Question: Give a one-sentence summary of this figure.
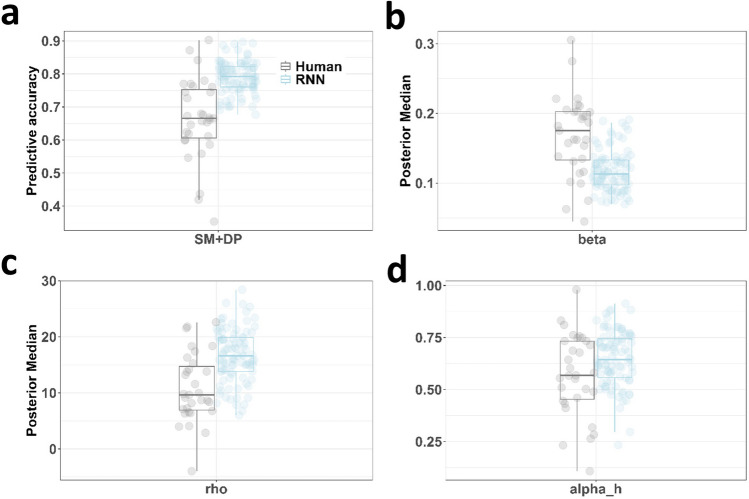
Answer: Median posterior values of model parameters for the best-fitting model for RNN agents (Bayesian learner with higher order perseveration term, SM + DP). ( a ) Predictive accuracy as the fraction of choices correctly predicted by the computational model of behavior, ( b ) choice stochasticity parameter β, ( c ) perseveration parameter \documentclass[12pt]{minimal} \usepackage{amsmath} \usepackage{wasysym} \usepackage{amsfonts} \usepackage{amssymb} \usepackage{amsbsy} \usepackage{mathrsfs} \usepackage{upgreek} \setlength{\oddsidemargin}{-69pt} \begin{document}$$\uprho$$\end{document} ρ , ( d ) Habit step size parameter \documentclass[12pt]{minimal} \usepackage{amsmath} \usepackage{wasysym} \usepackage{amsfonts} \usepackage{amssymb} \usepackage{amsbsy} \usepackage{mathrsfs} \usepackage{upgreek} \setlength{\oddsidemargin}{-69pt} \begin{document}$${\mathrm{\alpha }}_{{\mathrm{h}}}$$\end{document} α h